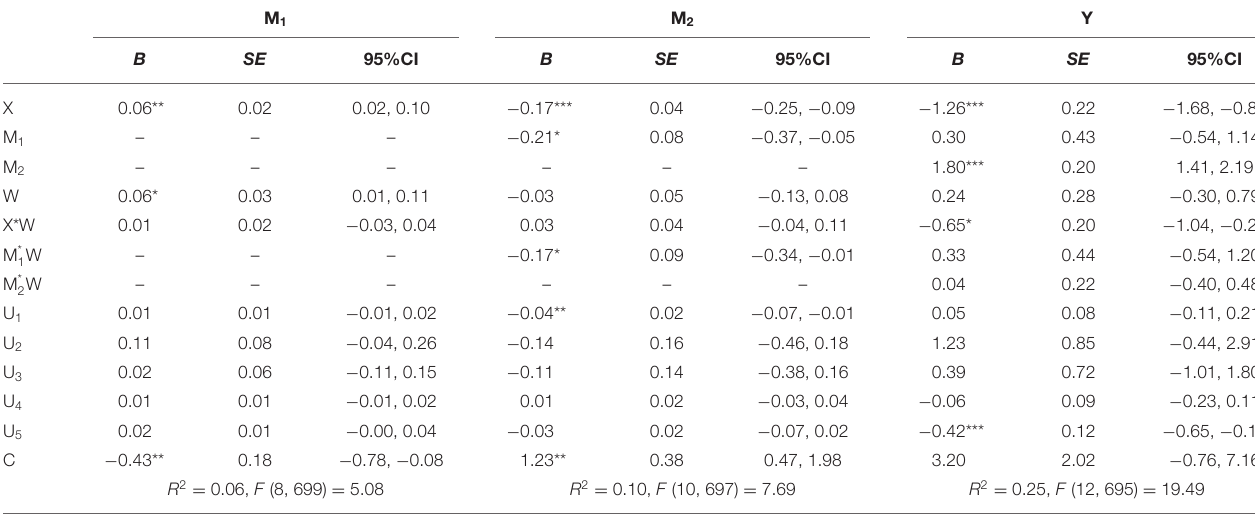
TABLE 3 | The summary of the moderated serial multiple mediation model.